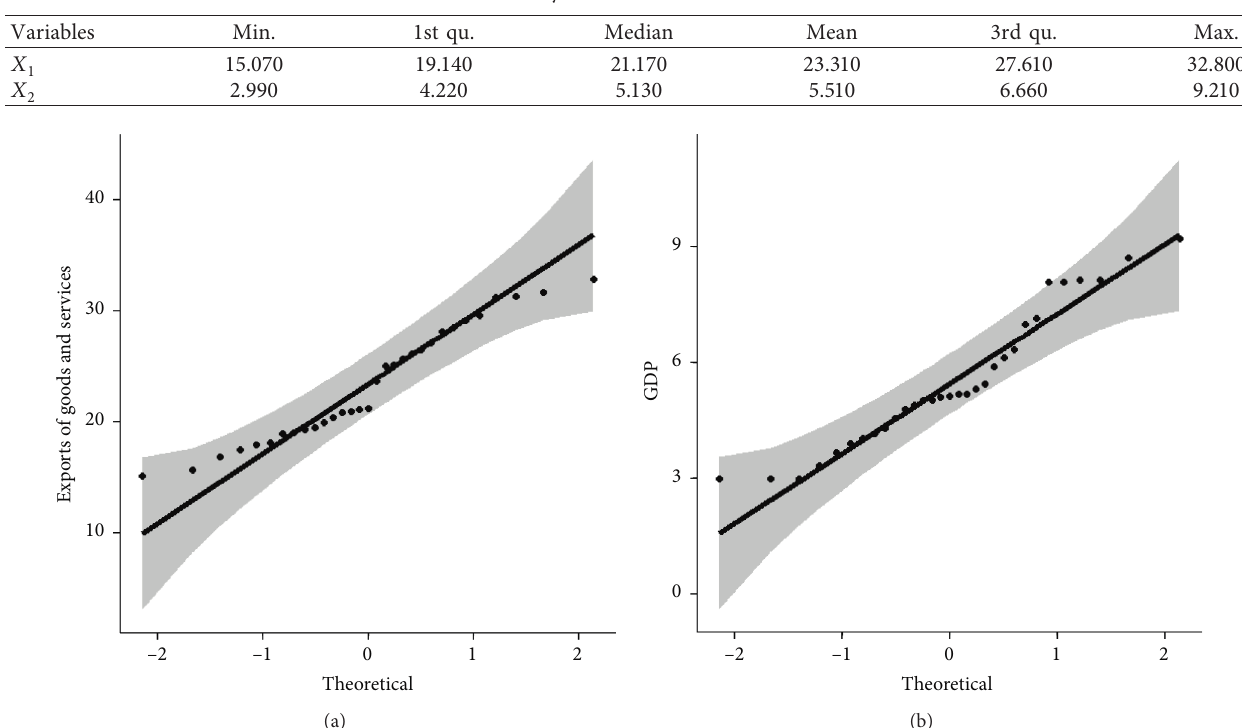
Figure 12: The fitted pdf, cdf, PP, and Kaplan–Meier survival and QQ plots of the L-Claim distribution along with the box plot of the data. Table 5: Summary measures of the economics data.